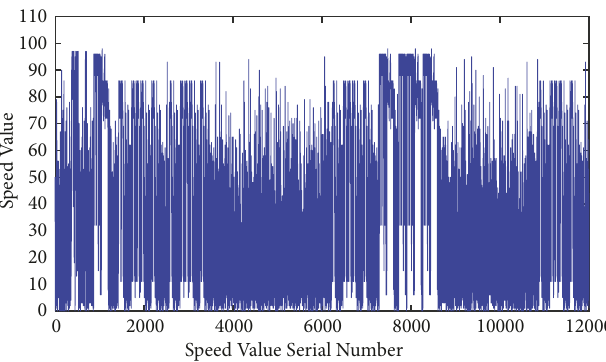
Figure 2: Velocity curve after data